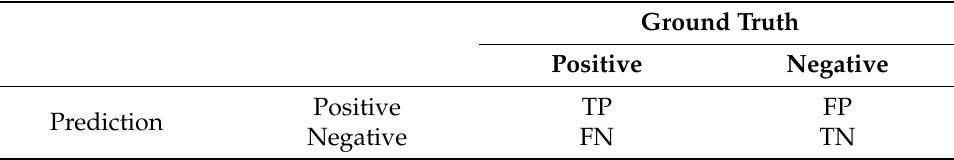
Table 3. Confusion matrix of classification indicators.